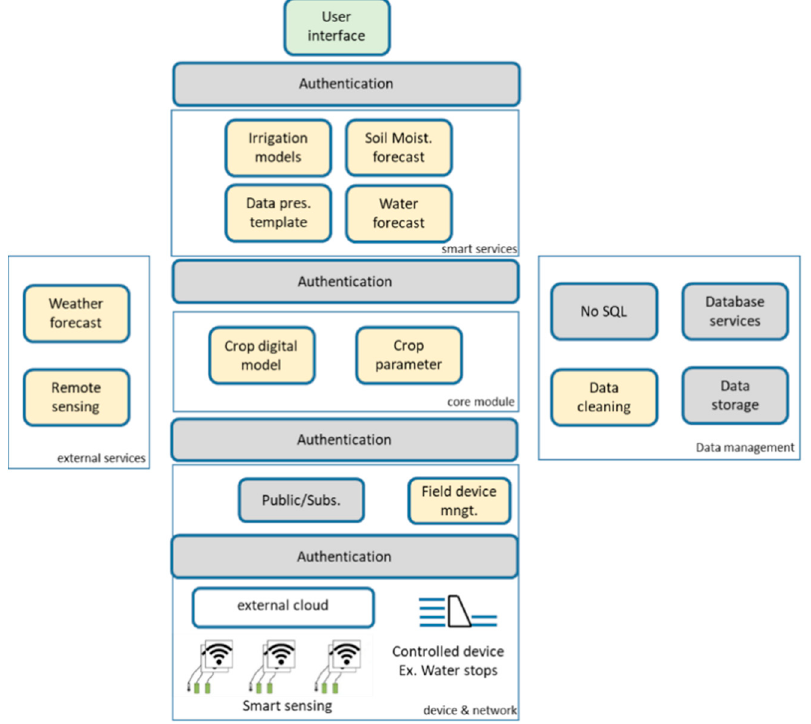
Figure 4. Modules and microservices that compose the IRRISENS IoT platform. Application-specific services (ASS) directly related to agriculture are indicated in yellow colour while general cloud services (GCS) are indicated in grey colour.